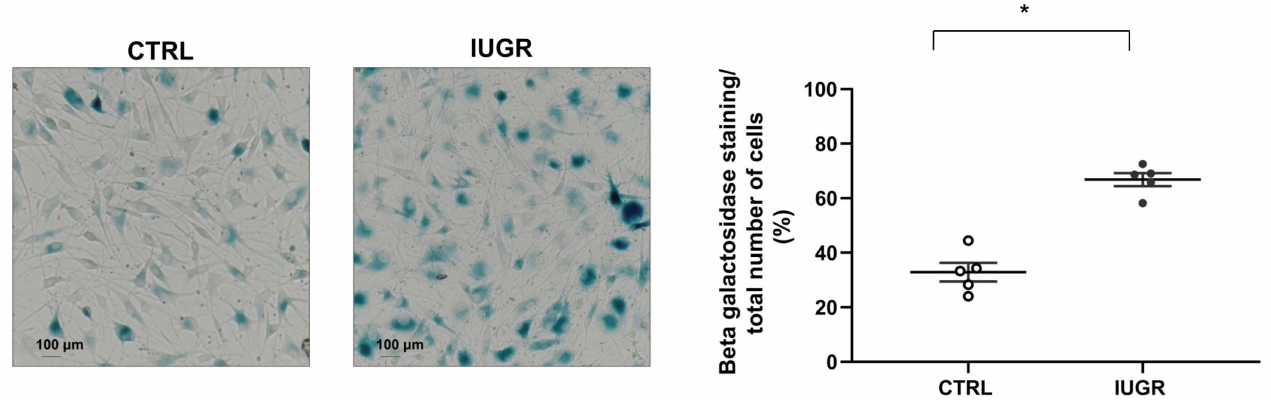
Figure 10. Beta-galactosidase activity in ECFCs. Beta-galactosidase activity was determined as the blue staining normalized to the total number of cells in CTRL-ECFCs and IUGR-ECFCs isolated from six-month-old male rats. Magnification (20 × ). These pictures are representative images from n = 5 animals/group; * p < 0.05. Scale bar = 100 µ m.